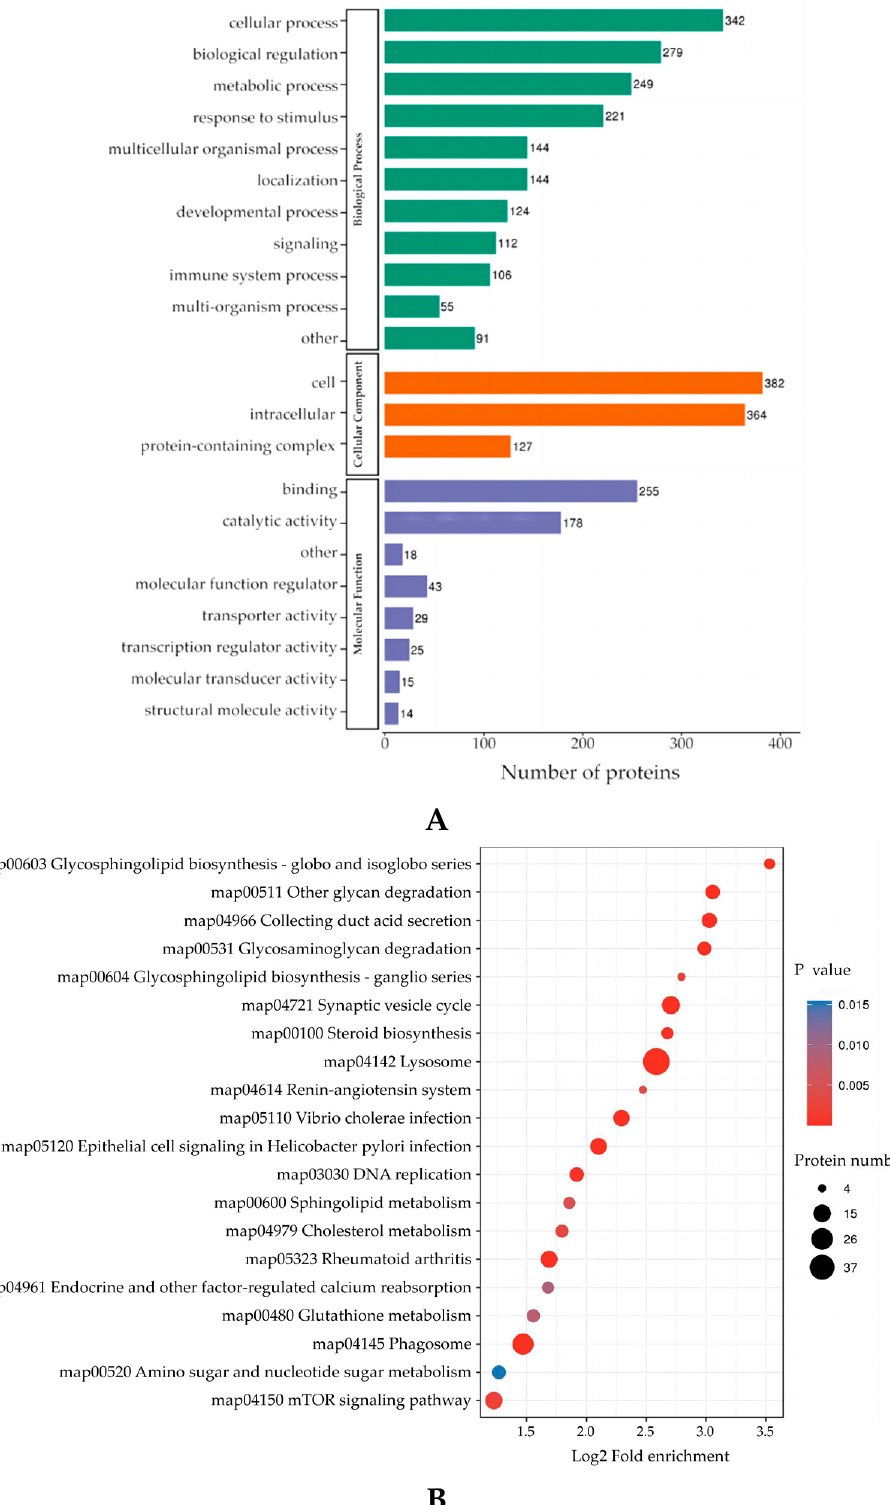
Figure 3. Analysis of DEPs by GO functional annotation and KEGG signaling pathway enrich- ment. ( A ) GO enrichment elaborates the differential protein functions in terms of biological pro- cesses, cellular components, and molecular functions. ( B ) The KEGG pathway enrichment bubble plot showed the functional classification and pathway from significant enrichment ( P value < 0.05) of